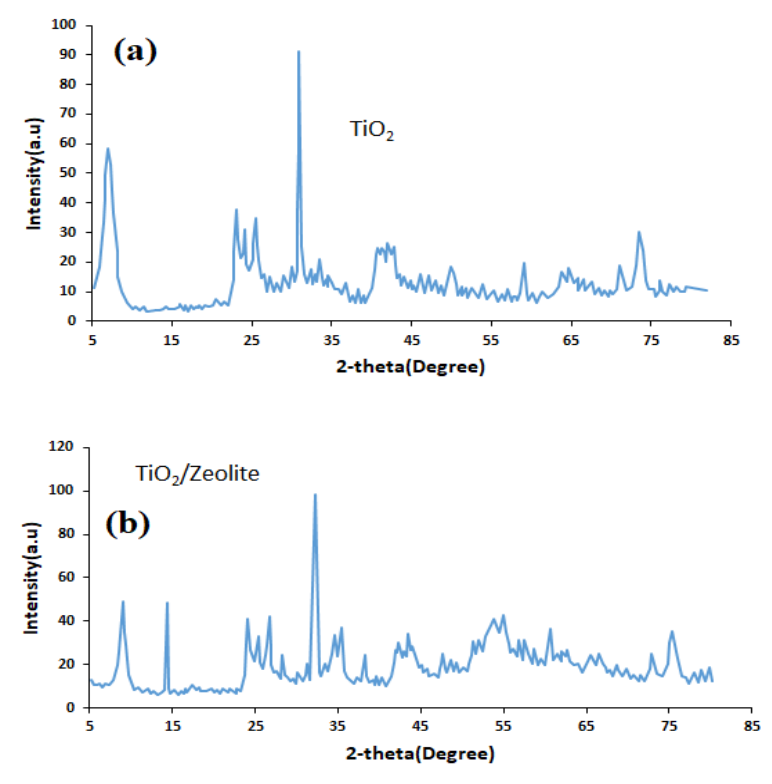
Fig. 2. XRD patterns of TiO